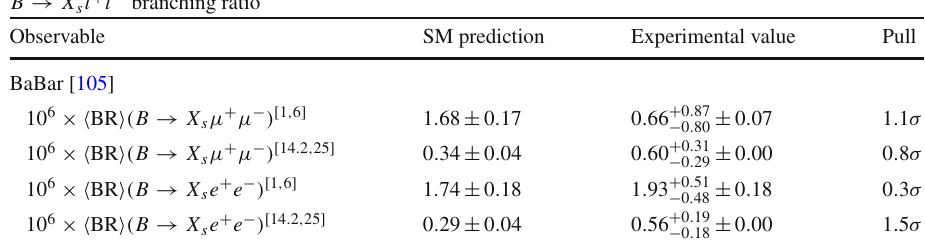
Table 22 Binned B → X s l + l − branching ratio included in the global fit